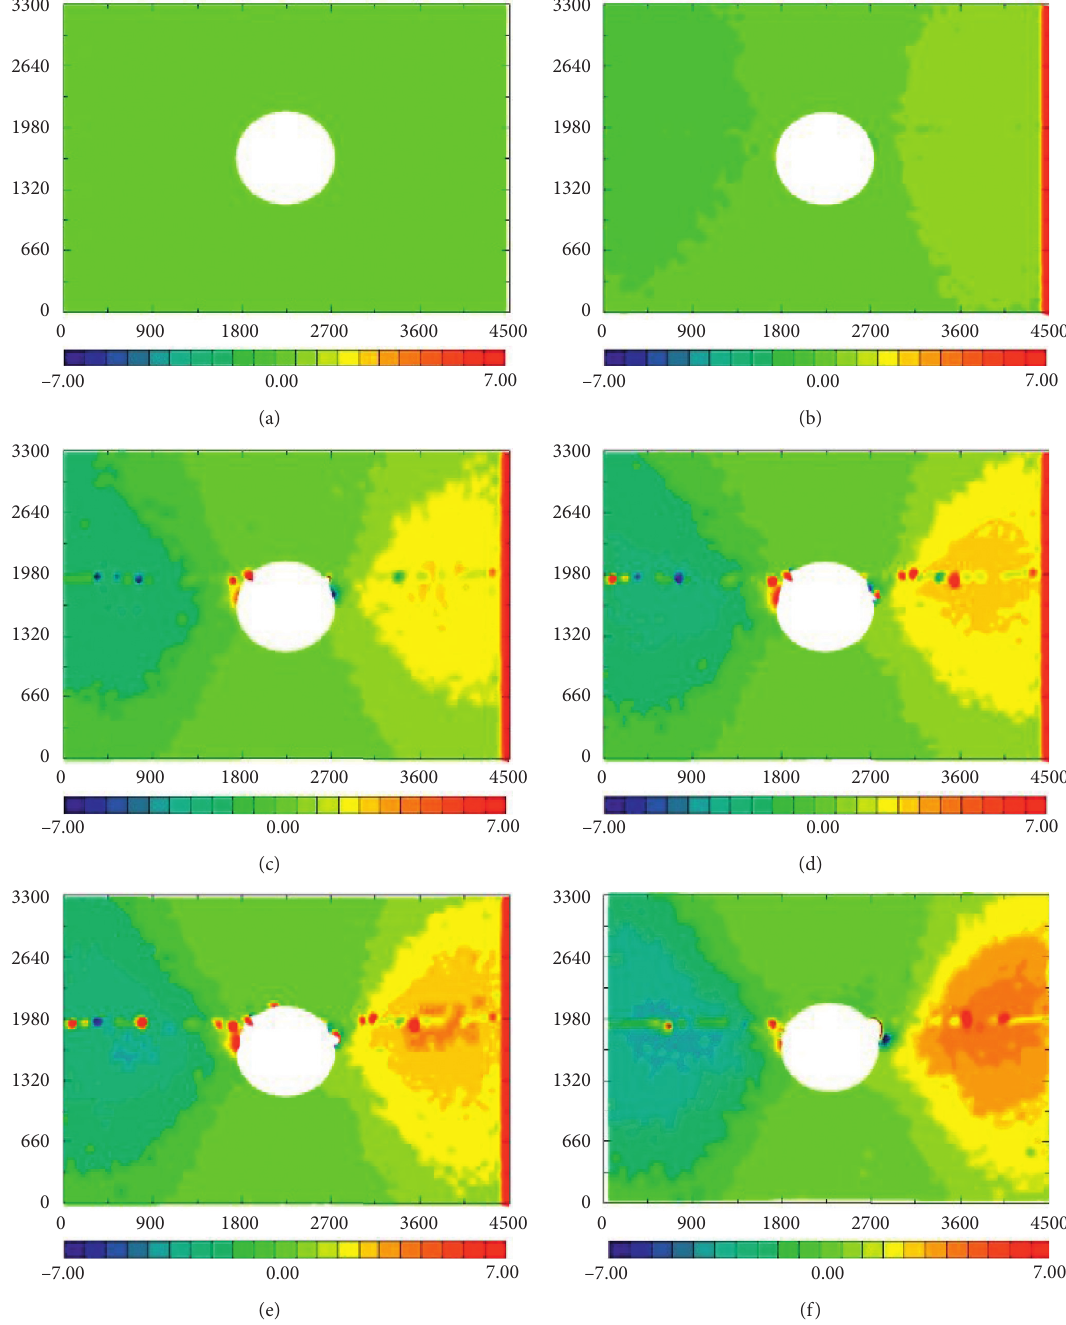
Figure 11: Horizontal displacement cloud map of unsupported model. (a) 0.25 MPa. (b) 0.40MPa. (c) 0.47MPa. (d) 0.51MPa. (e) 0.52MPa. (f)